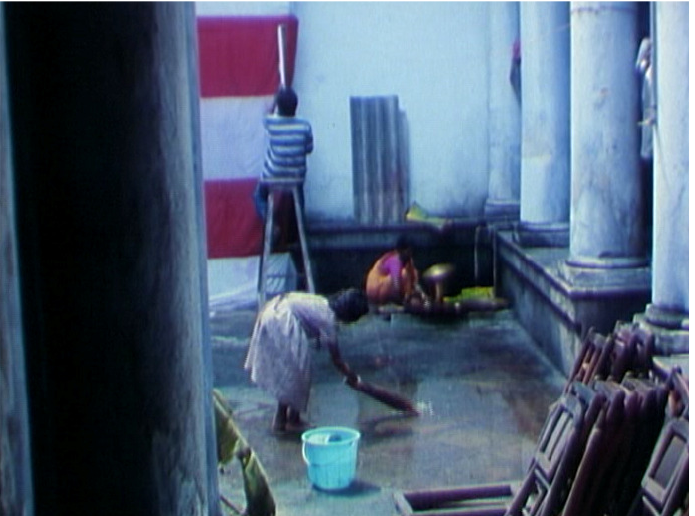
Figure 11. Preparing the courtyard, screen grab, Utsab